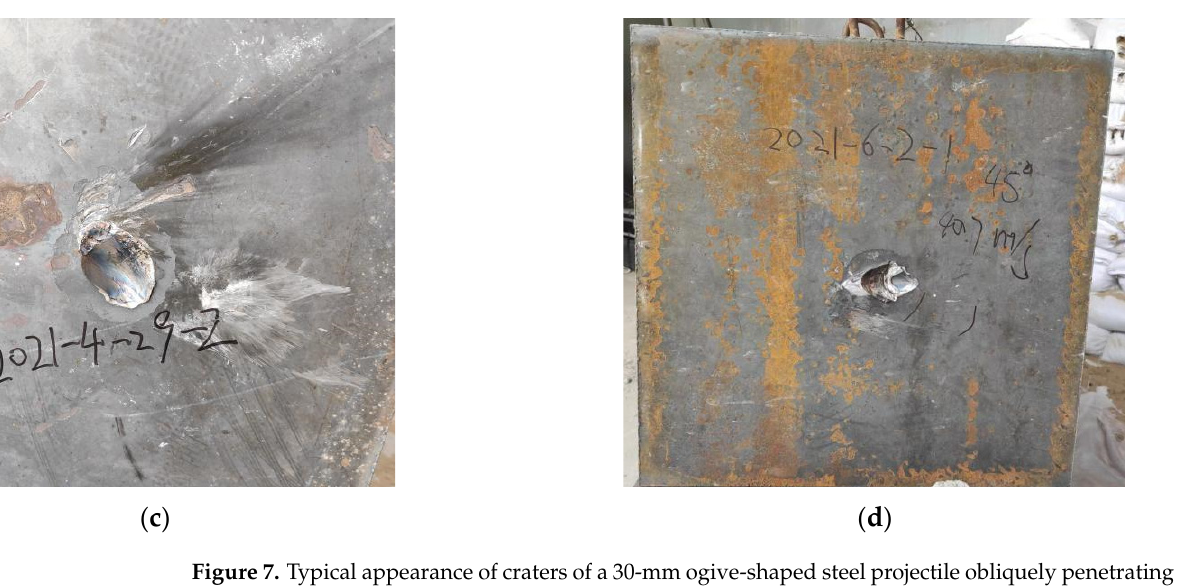
Figure 7. Typical appearance of craters of a 30-mm ogive-shaped steel projectile obliquely penetrating a 90-mm steel target plate at different striking velocities and obliquities: ( a ) 789 m/s, 15 ◦ obliquity; ( b ) 570 m/s, 25 ◦ obliquity; ( c ) 315 m/s, 30 ◦ obliquity and ( d ) 407 m/s, 45 ◦ obliquity.